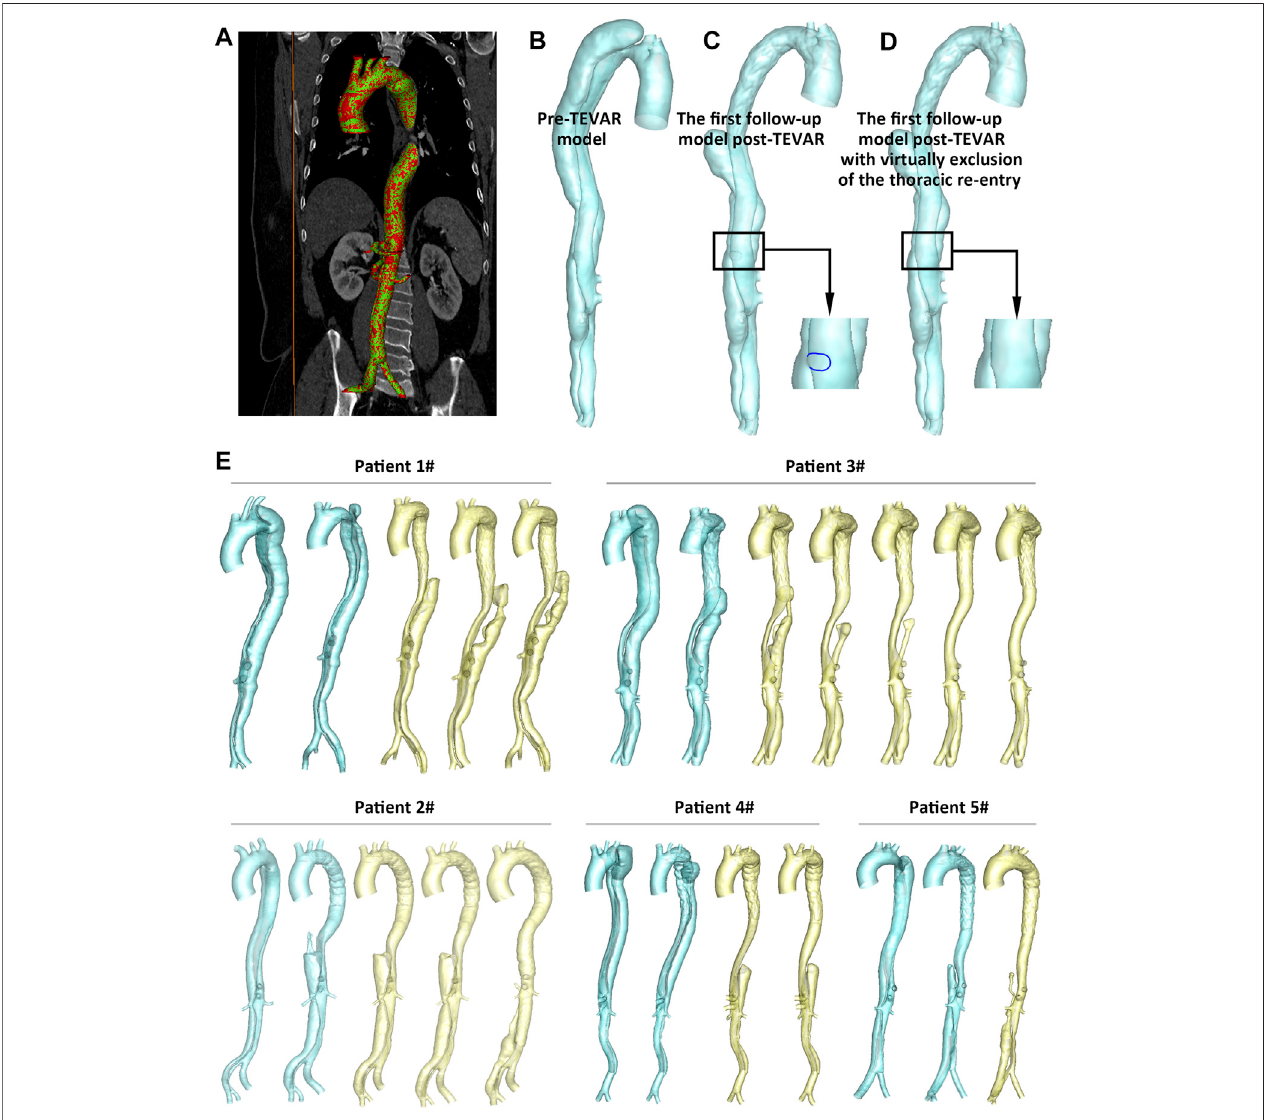
FIGURE 1 | (A) Segmentation of the CTA image datasets and mapping back of the 3D reconstructed model to the original medical image. (B – D) As a representative, the pre- and post-TEVAR models and the arti fi cially modi fi ed model of patient 2# were shown. (E) Geometric models of all of the cases with multiple image examinations were